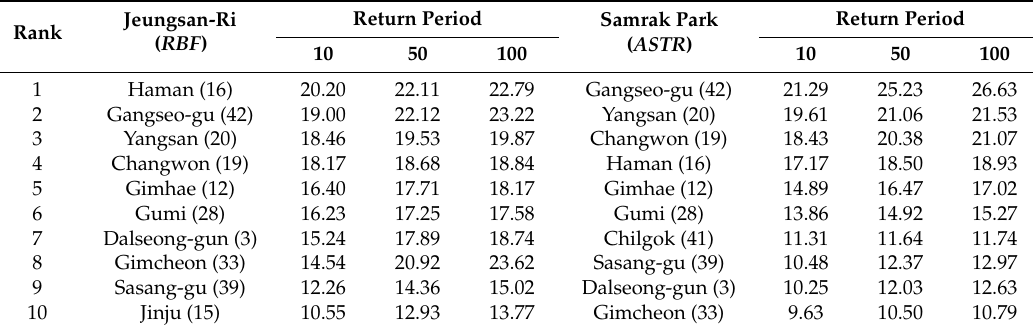
Table 4. Comparison of ranks and potential risk as the return period